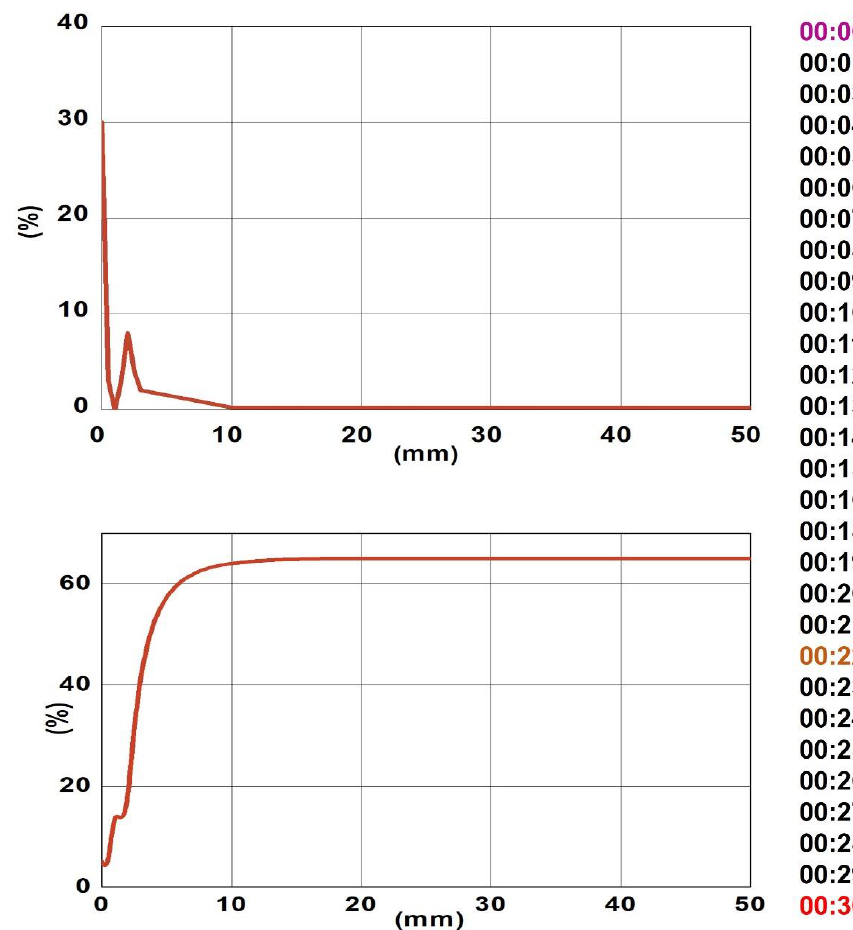
Figure 8. Delta backscattering measurements of 40:60 PG/W-based ZnO nanofluids 1.5 vol%.